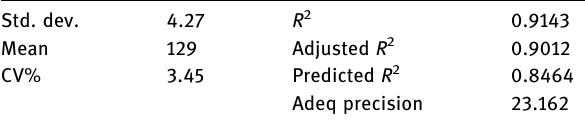
Table 10: Fit statistics for compression modulus